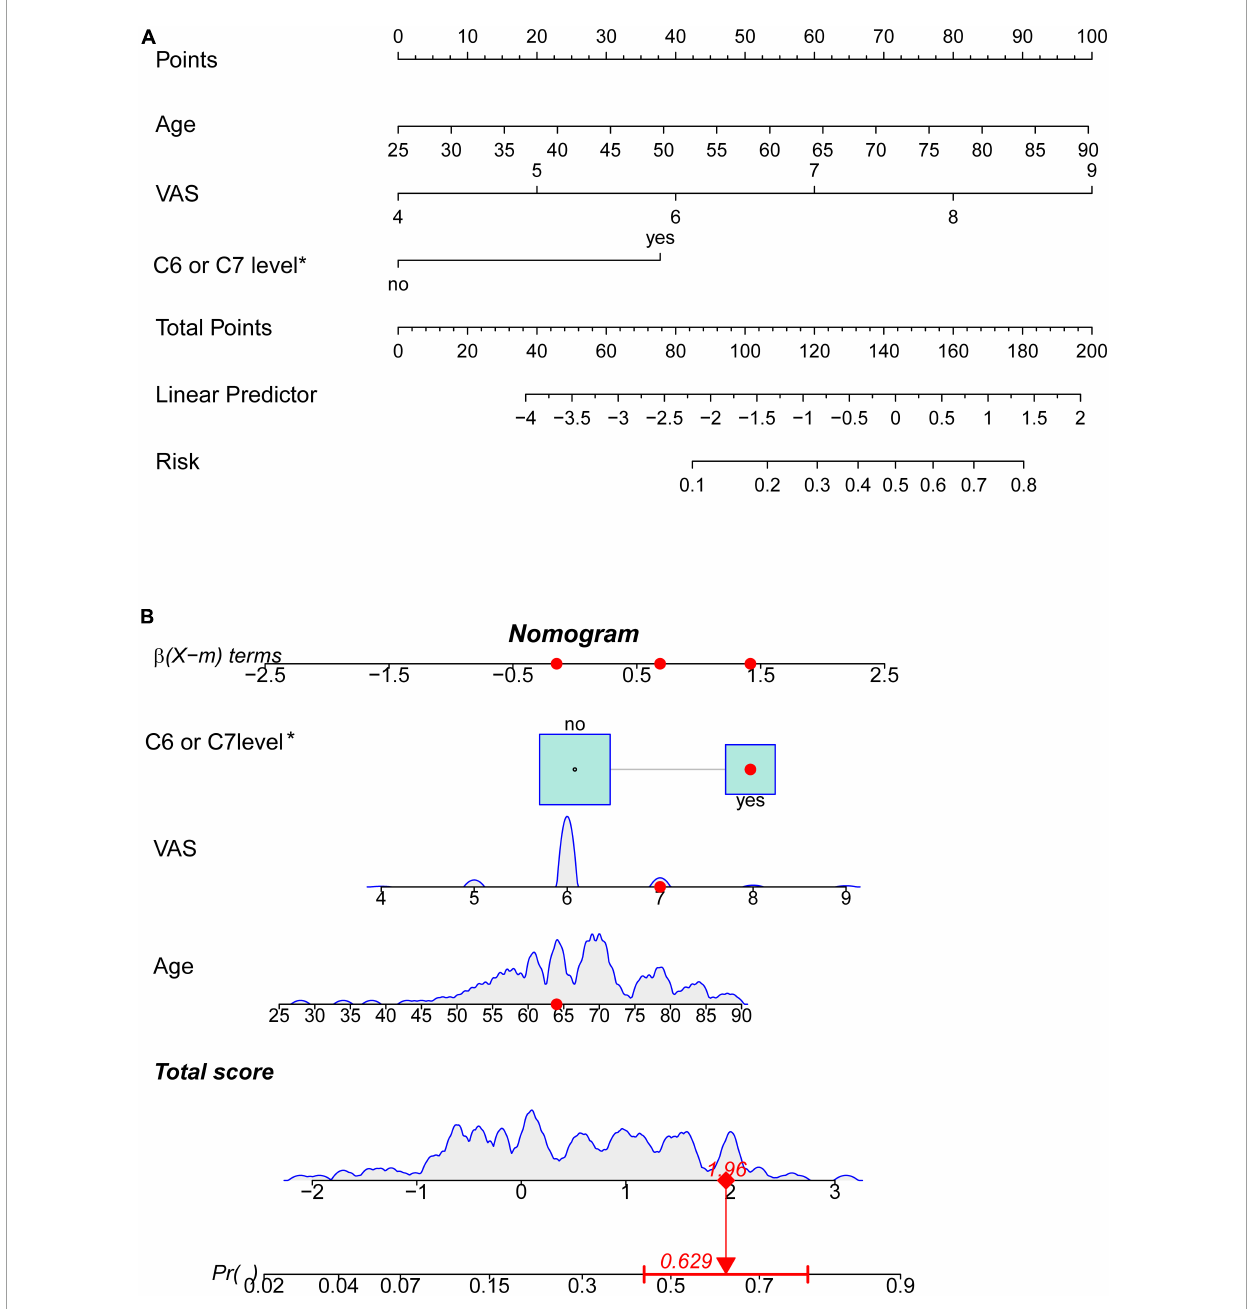
FIGURE3 Nomogram prediction model (*involving C6 or C7 nerve roots). (A) Nomogram based on three risk factors to predict limb weakness probabilities of HZ patients. (B) The dynamic nomogram for an example. An HZ patient with less than 64 years, a VAS of 7, and involving C6 or C7 nerve roots has an estimated probability of limb weakness of